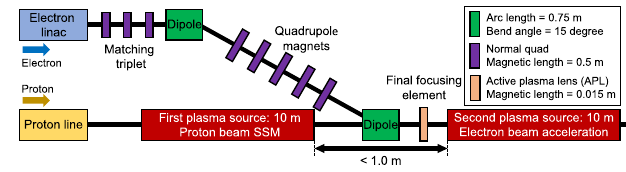
FIG. 1. Schematic view of the AWAKE RUN 2 experiment using two plasma sources (not to scale). The electron beam is generated by combining S- and X-band RF accelerators [18] and transported through the electron beamline. Normal quad indicates the normal electromagnetic quadrupole magnet. Note that the beamline in this schematic view, including the final focusing element, is not the baseline of the AWAKE experiment (i.e., the baseline does not consider using an